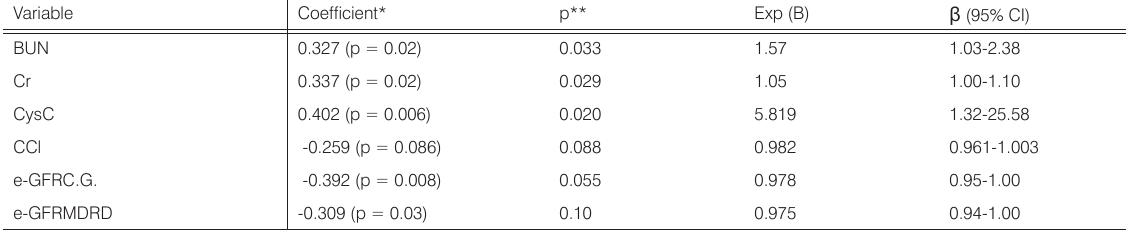
Table 3. Spearman’s correlation and univariate regression analysis of the variables for one-year mortality Variable